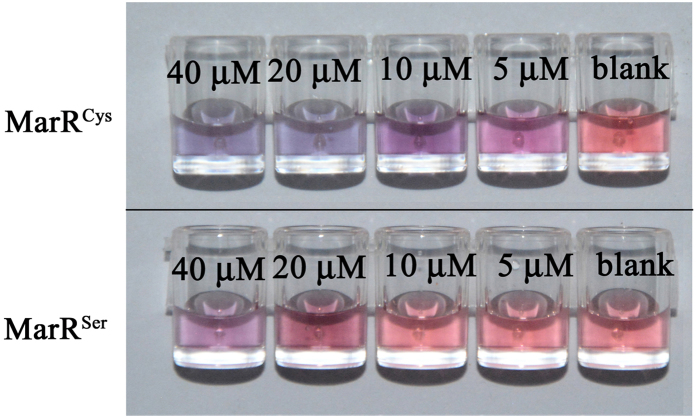
Colourimetric response of wild-type MarR (MarRCys) and mutant (MarRser) functionalized gold nanoparticles versus the Cu2+ concentration.